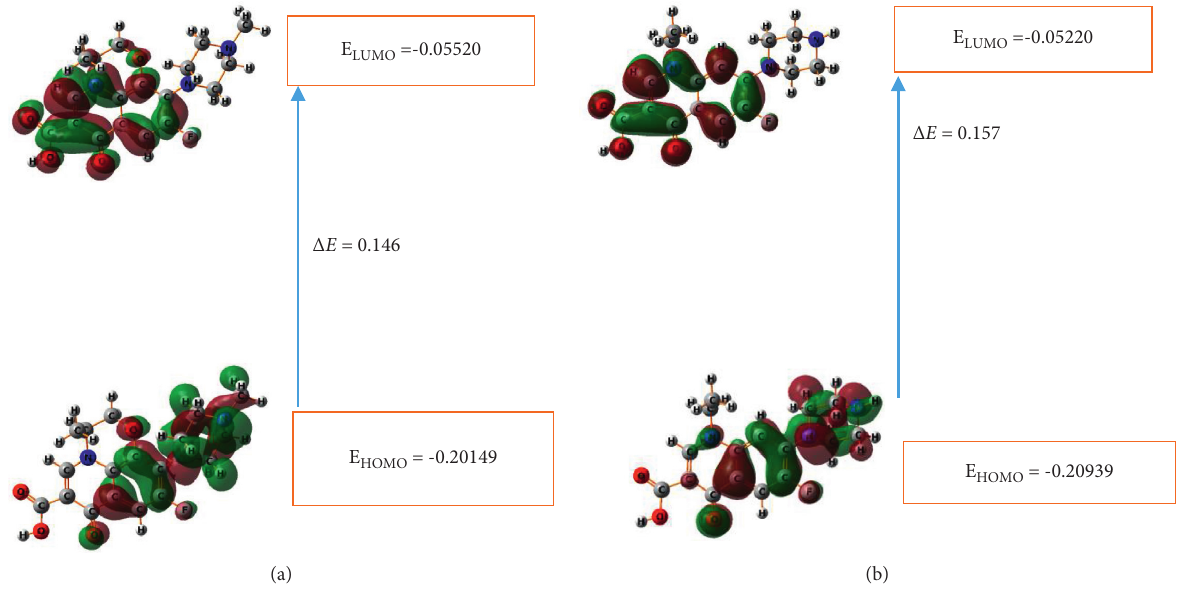
Figure 8: The HOMO-LUMO energy, band gap energy, and structure of (a) LVF and (b) NRF using DFT-B3LYP-6-31G.